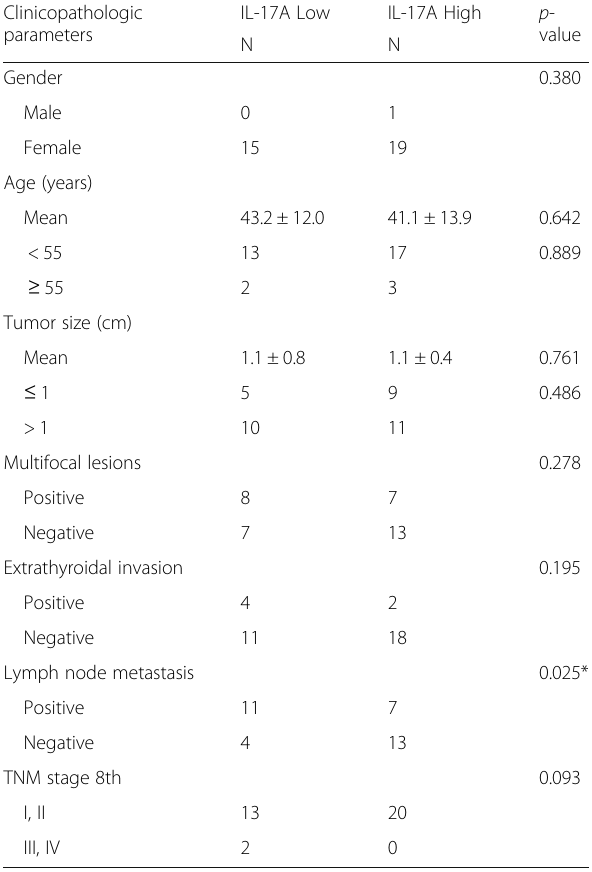
Table 2 Clinical characteristics of PTC + HT patients in the qPCR cohort ( n = 35) Clinicopathologic